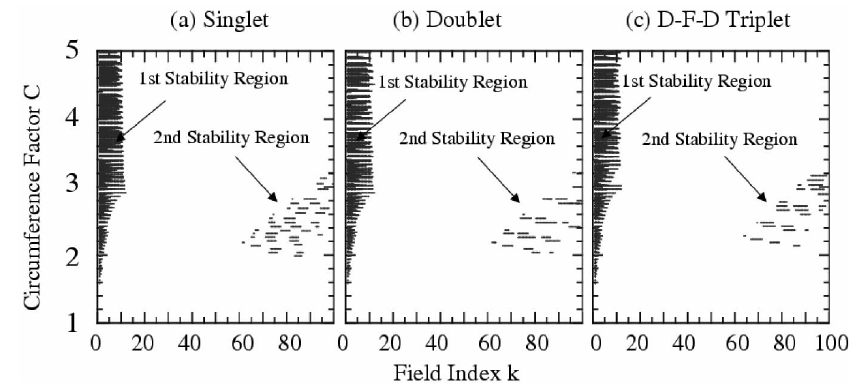
FIG. 2. Stability islands of the 12 cell radial-sector type are compared in the k - C plane for three different configurations: